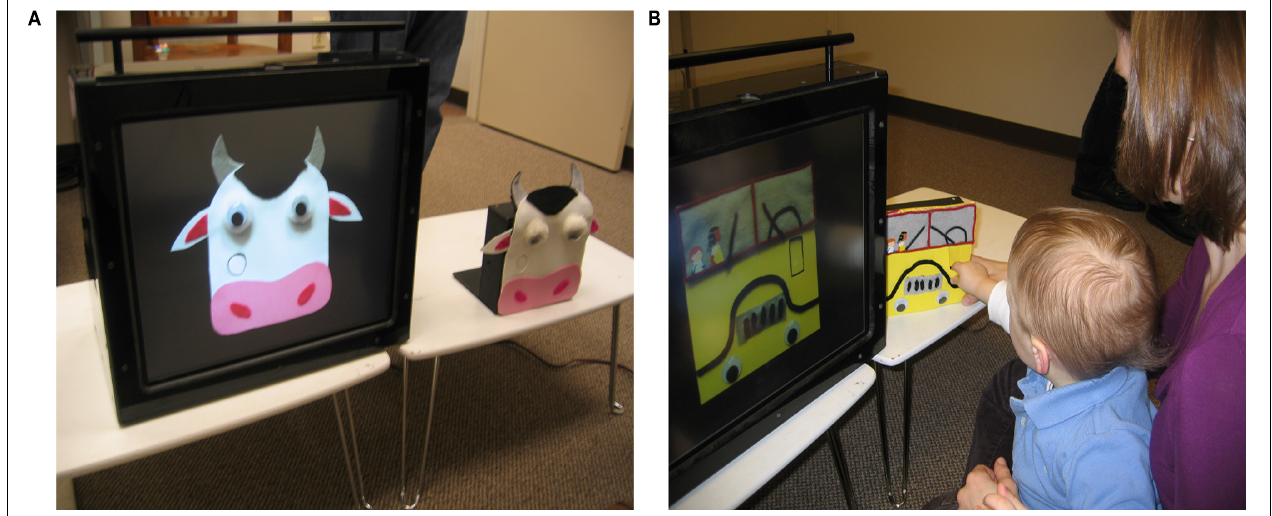
FIGURE 1 | (A) 2D touch screen and 3D object experimental stimuli. (B) Set-up for the touch screen teaching task.